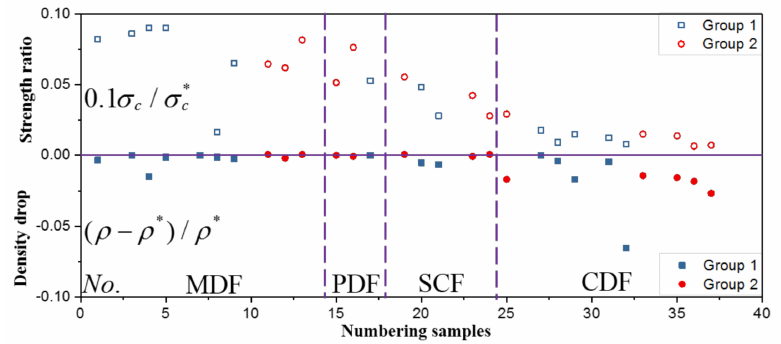
Figure 9. Density drop and strength ratio distribution (minus means decrease).